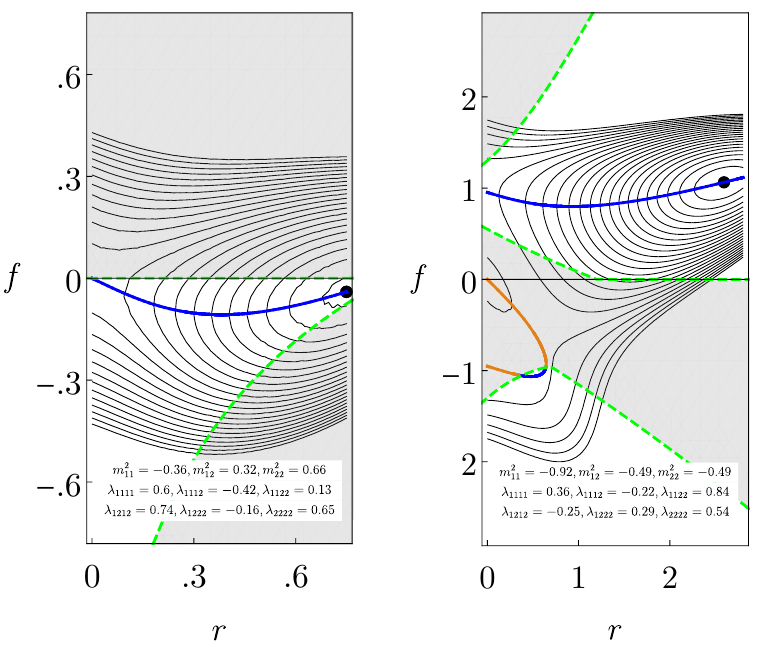
Figure 3 . EFT submanifolds in the 2HQM obtained by matching in the unitary basis for two representative sets of parameters, one with m 2 > 0 (left panel) and the other with m 2 < 0 (right 22 22 panel). In each panel, contours of the potential eq. (7.29) are shown in the ( r, f ) plane in arbitrary mass units with the indicated choice of parameters. We have fixed β i = 0 . The location of the global minimum is denoted by a black dot, while the fixed point corresponds to ( r, f ) = (0 , 0) . The EFT submanifolds are shown in blue and orange; blue corresponds to solution(s) of ∂V = 0 in regions ∂f where the UV fluctuations (in f and β i ) have positive definite mass matrix, and orange otherwise. The region in which the UV fluctuations do not have positive definite mass matrix is shown in light gray, with a dashed green boundary. In the left panel, the choice of parameters (namely m 2 > 0 ) 22 admits SMEFT, as illustrated by the existence of an EFT submanifold connecting the UV fixed point to the global minimum through a region of positive definite mass matrix. In the right panel, the choice of parameters (namely m 2 < 0 ) requires HEFT, as none of the EFT submanifolds 22 connect the fixed point to the global